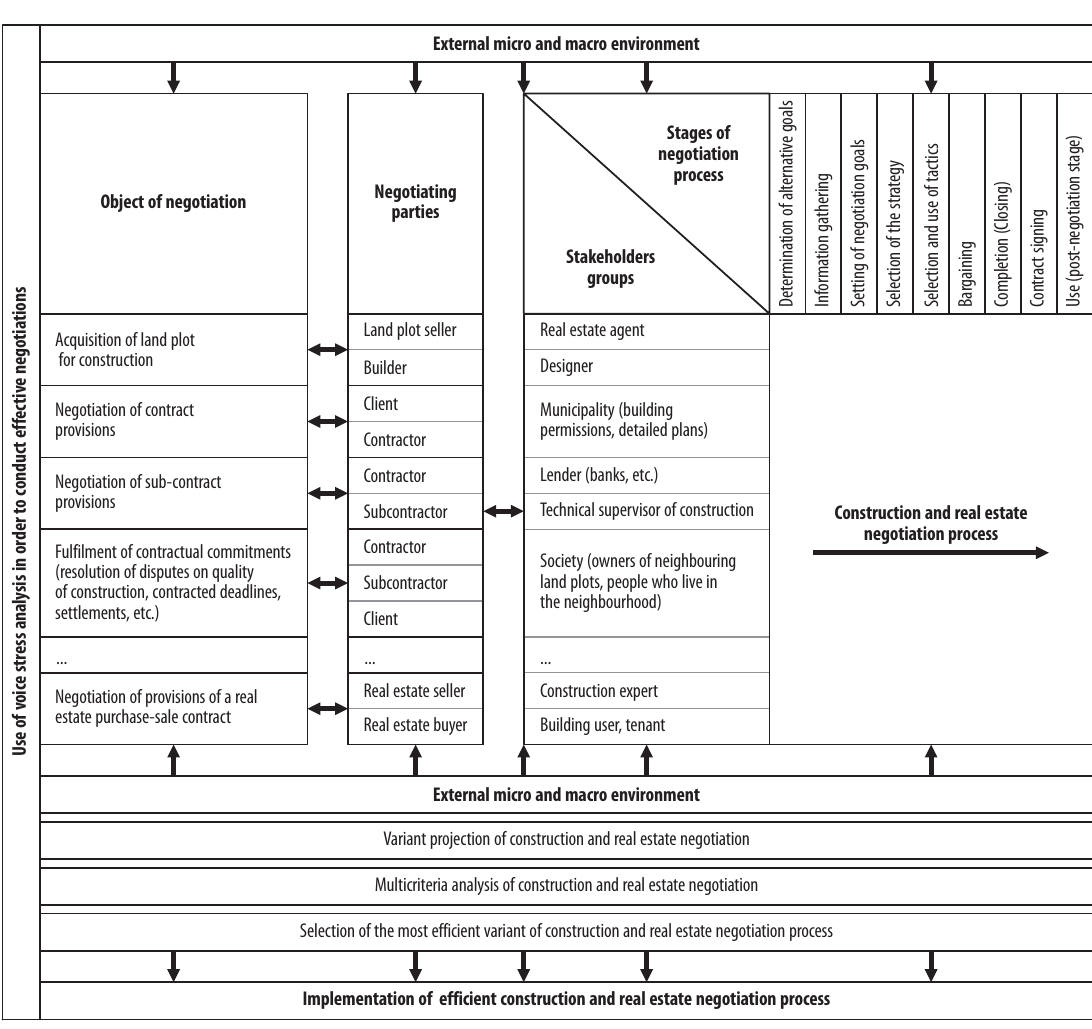
Figure 2. The model for multiple criteria analysis of construction and real estate